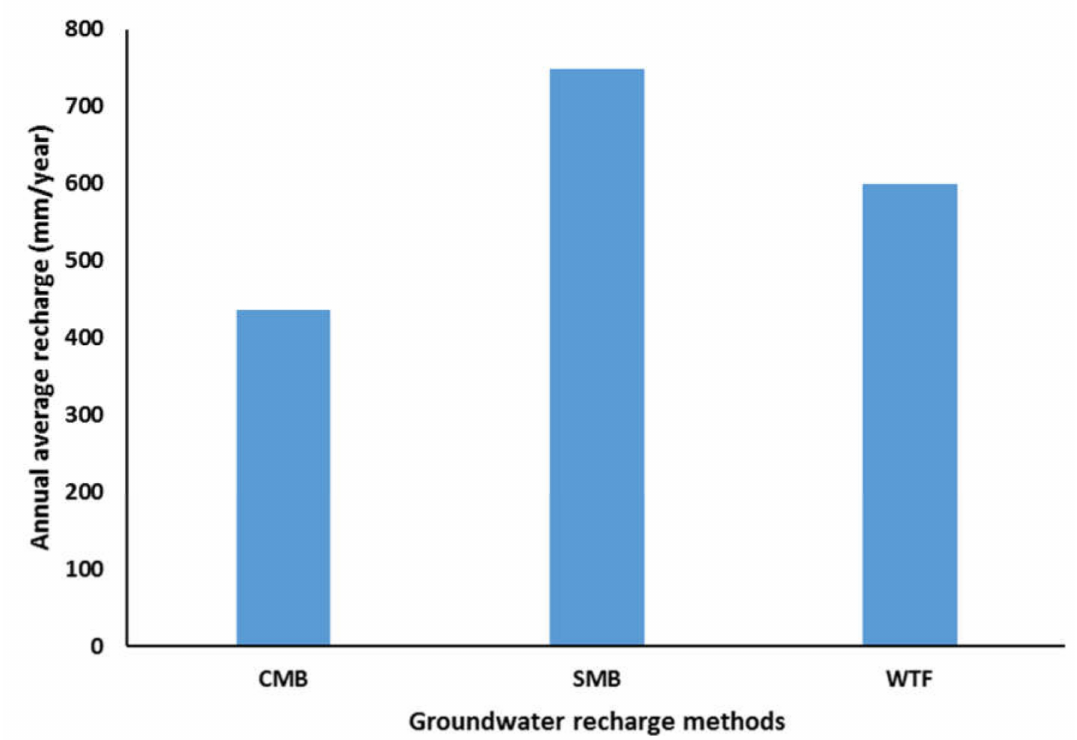
Figure 9. Comparison of results of di ff erent groundwater recharge estimation